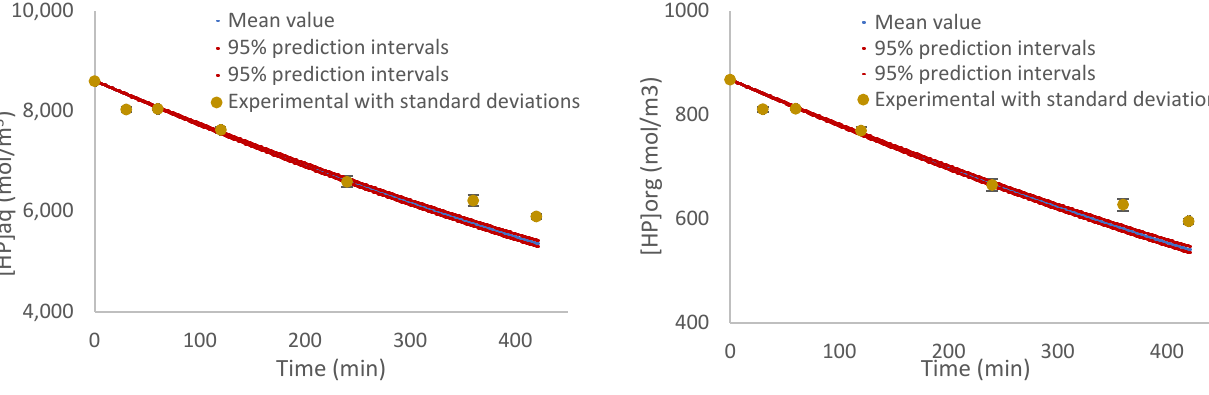
Figure A4. Prediction intervals of 95% for the concentration of hydrogen peroxide in the aqueous and organic phases, using the average of the experimental data and setting K 1,org = 0 and K 1,aq = 15.05 for Experiment 9.